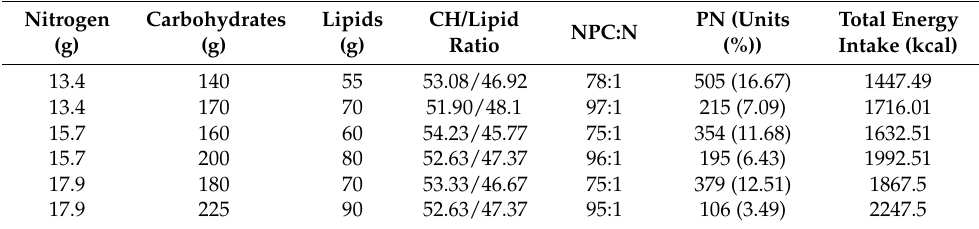
Table 2. Carbohydrate, lipid and macronutrient ratios along with total calories in prescribed PN formulae using nitrogen content as a reference.